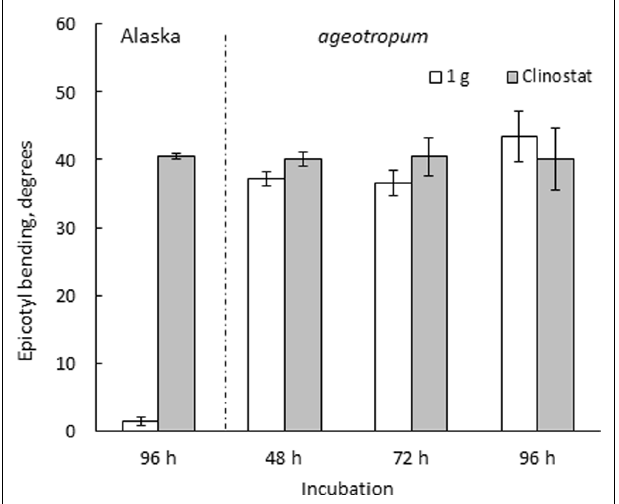
FIGURE 3 | Effects of 3-D clinostat rotation on the epicotyl bending in Alaska and ageotropum seedlings. Data bars: means with standard errors ( n = 10); time: h asw.